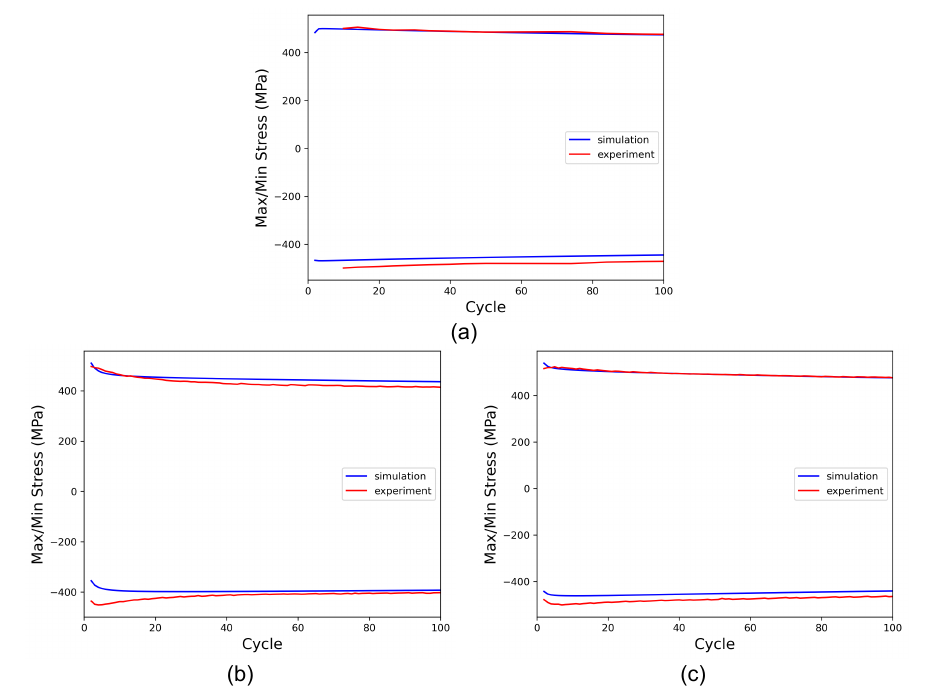
Figure 11. Comparison of maximum and minimum stress obtained in experiment and simulation during torsional cycles with ( a ) R = − 1, θ = 7.5 ◦ , comparison of cyclic softening behavior for the loading cases ( b ) R = 0, θ = 10 ◦ , and ( c ) R = 0, θ = 15 ◦ .